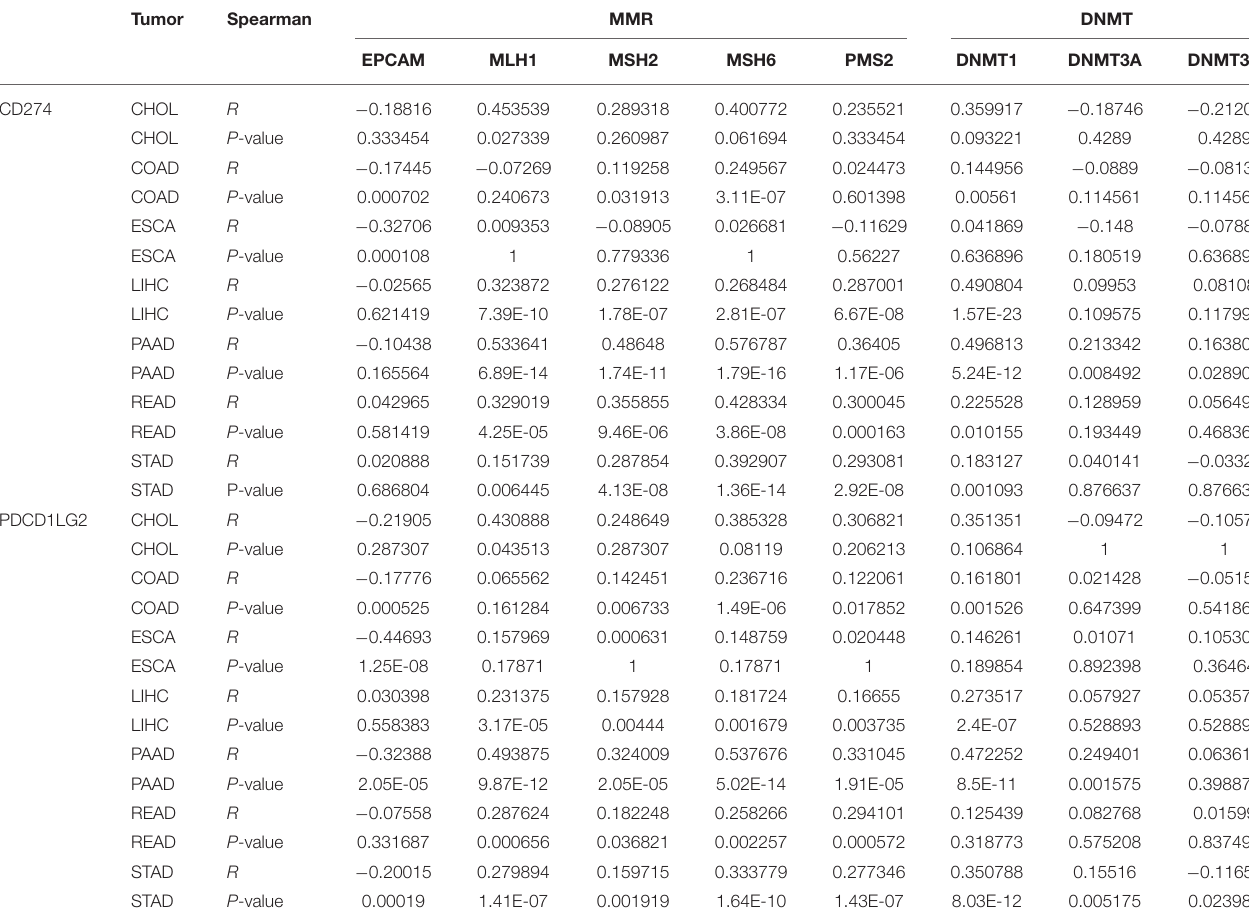
TABLE 1 | Correlation analysis of CD274/PDCD1LG2 expression with mismatch repair (MMR) and DNA methyltransferase (DNMT).